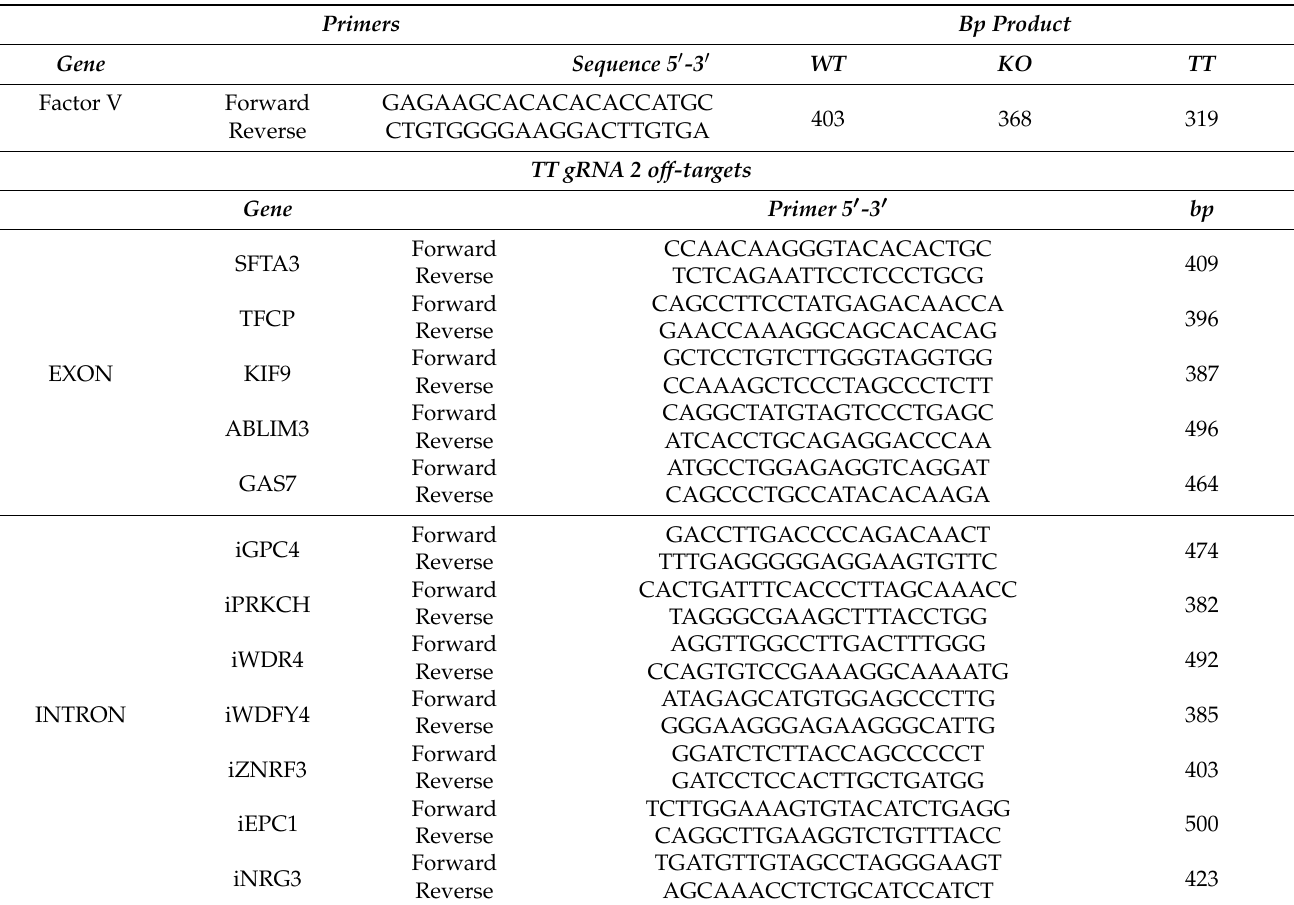
Table 3. Primers used to amplify F5 and off-target genes.